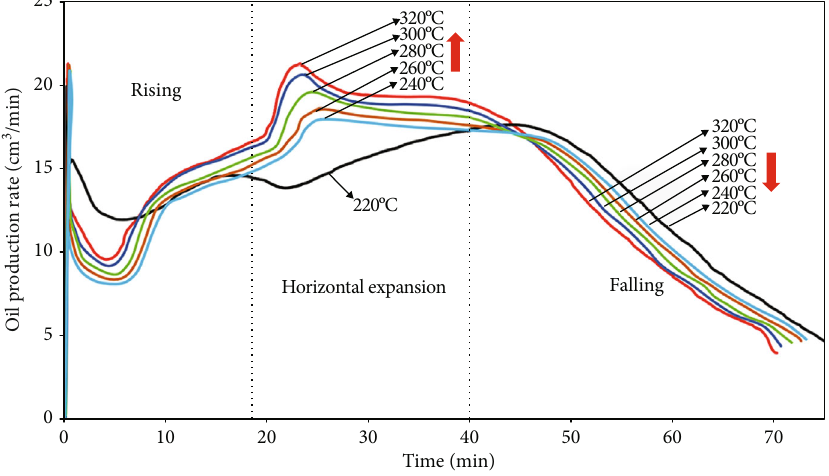
Figure 23: Oil production rate at di ff erent steam